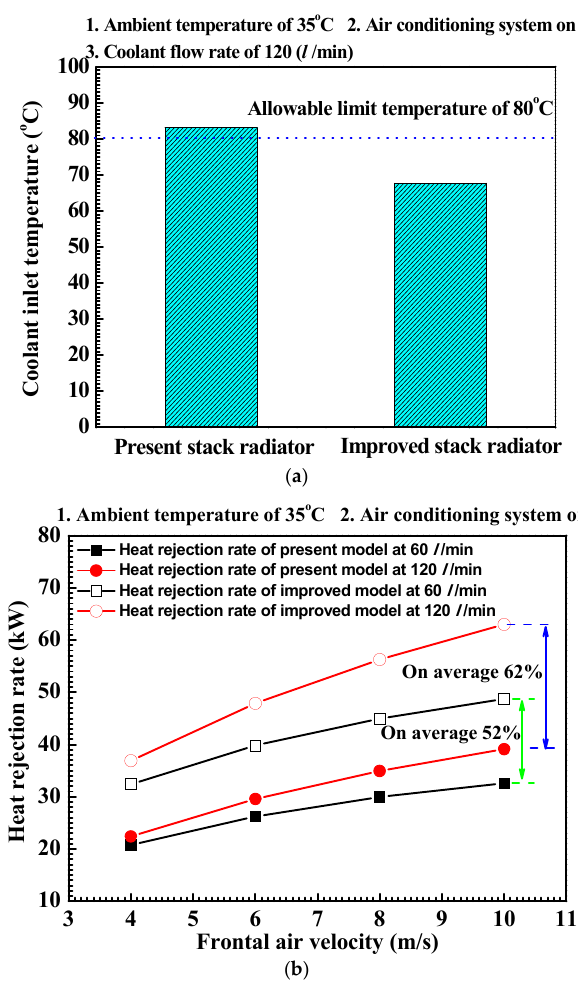
Figure 8. Comparison on the cooling performance of the stack thermal management system equipped with the improved and present stack radiator models. ( a ) Coolant inlet temperature; ( b ) Heat ‐ rejection rate.